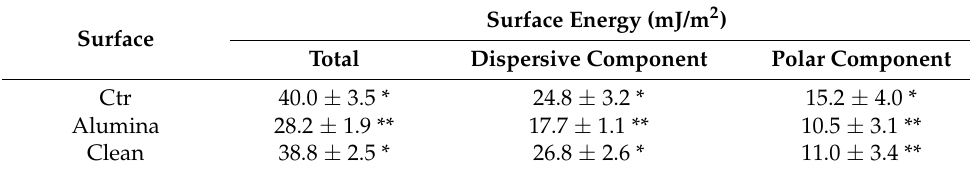
Table 3. Surface energy and its components for the different Ti surfaces. Values are mean ± standard deviation. Statistical differences for each column are indicated by single asterisk and double asterisk symbols ( p <